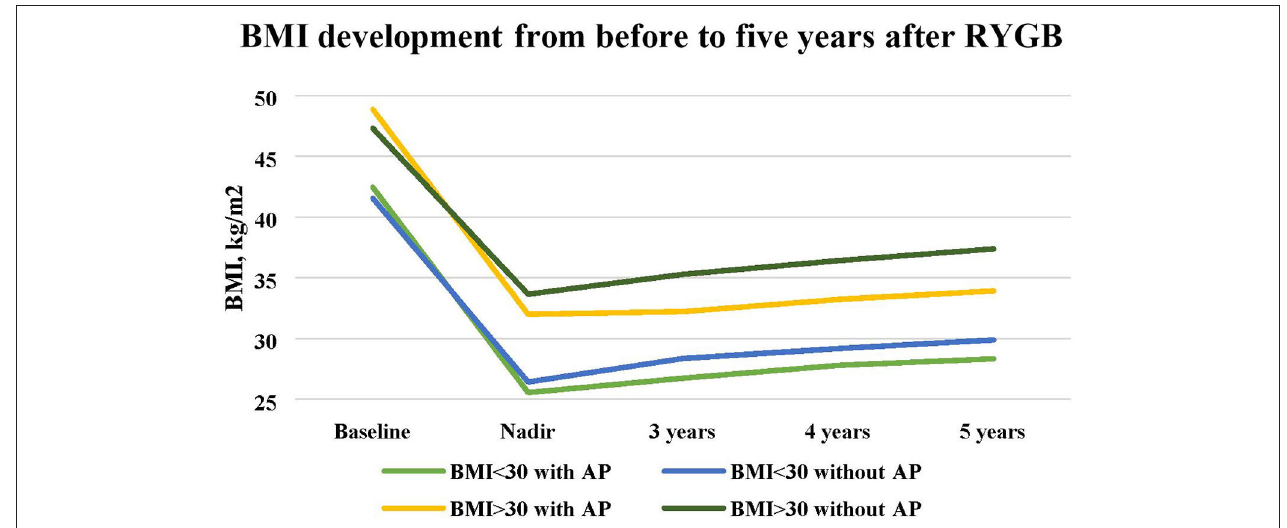
FIGURE 1 | Changes in mean BMI from baseline to 5 years after RYGB in patients with and without abdominoplasty and Nadir BMI above or below 30 kg/m 2 .